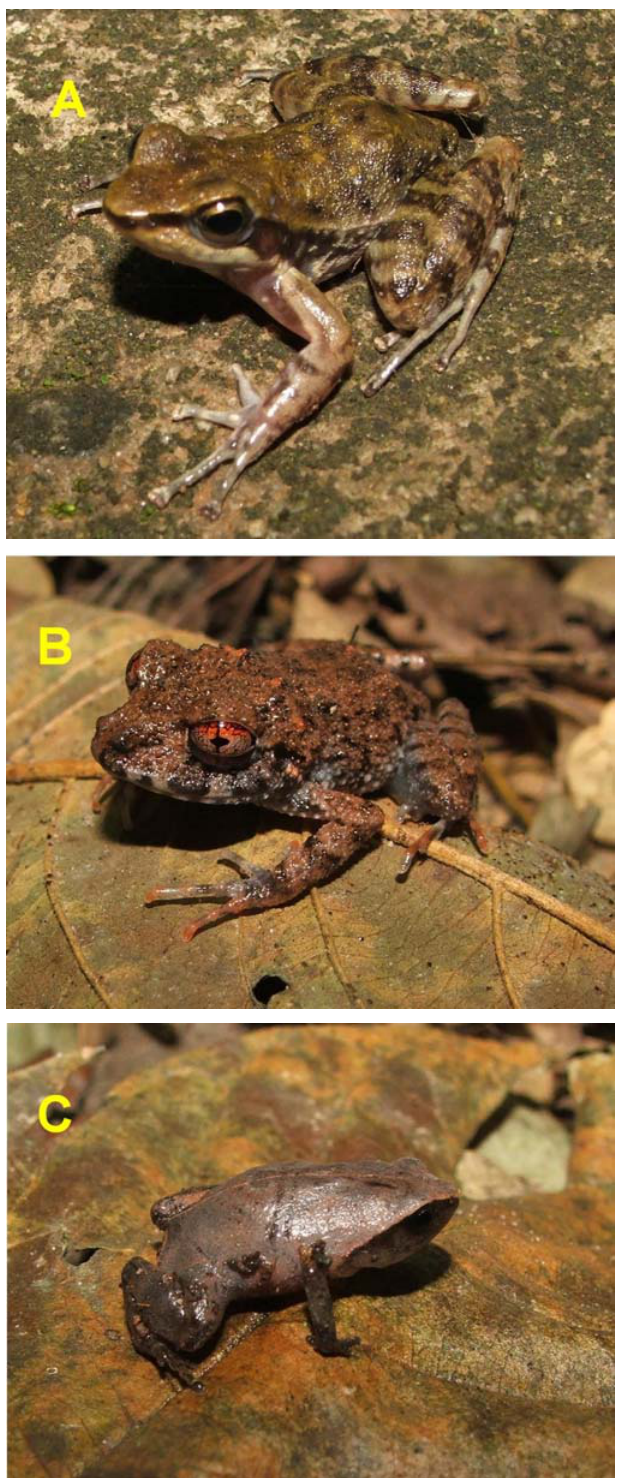
Figure 3 . Specimens of Hylodes charadranaetes (A) Ischnocnema octavioi (B) and Euparkerella cochranae (C) from Morro São João. Photos by D.